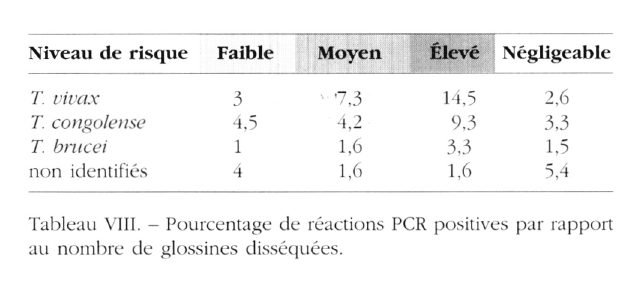
de la prospection (tableau VIII). Il apparaît que le pourcentage de glossines infectées par des trypano- somes pathogènes est, pour les trois espèces de para­ sites, d’autant plus important que la zone a été